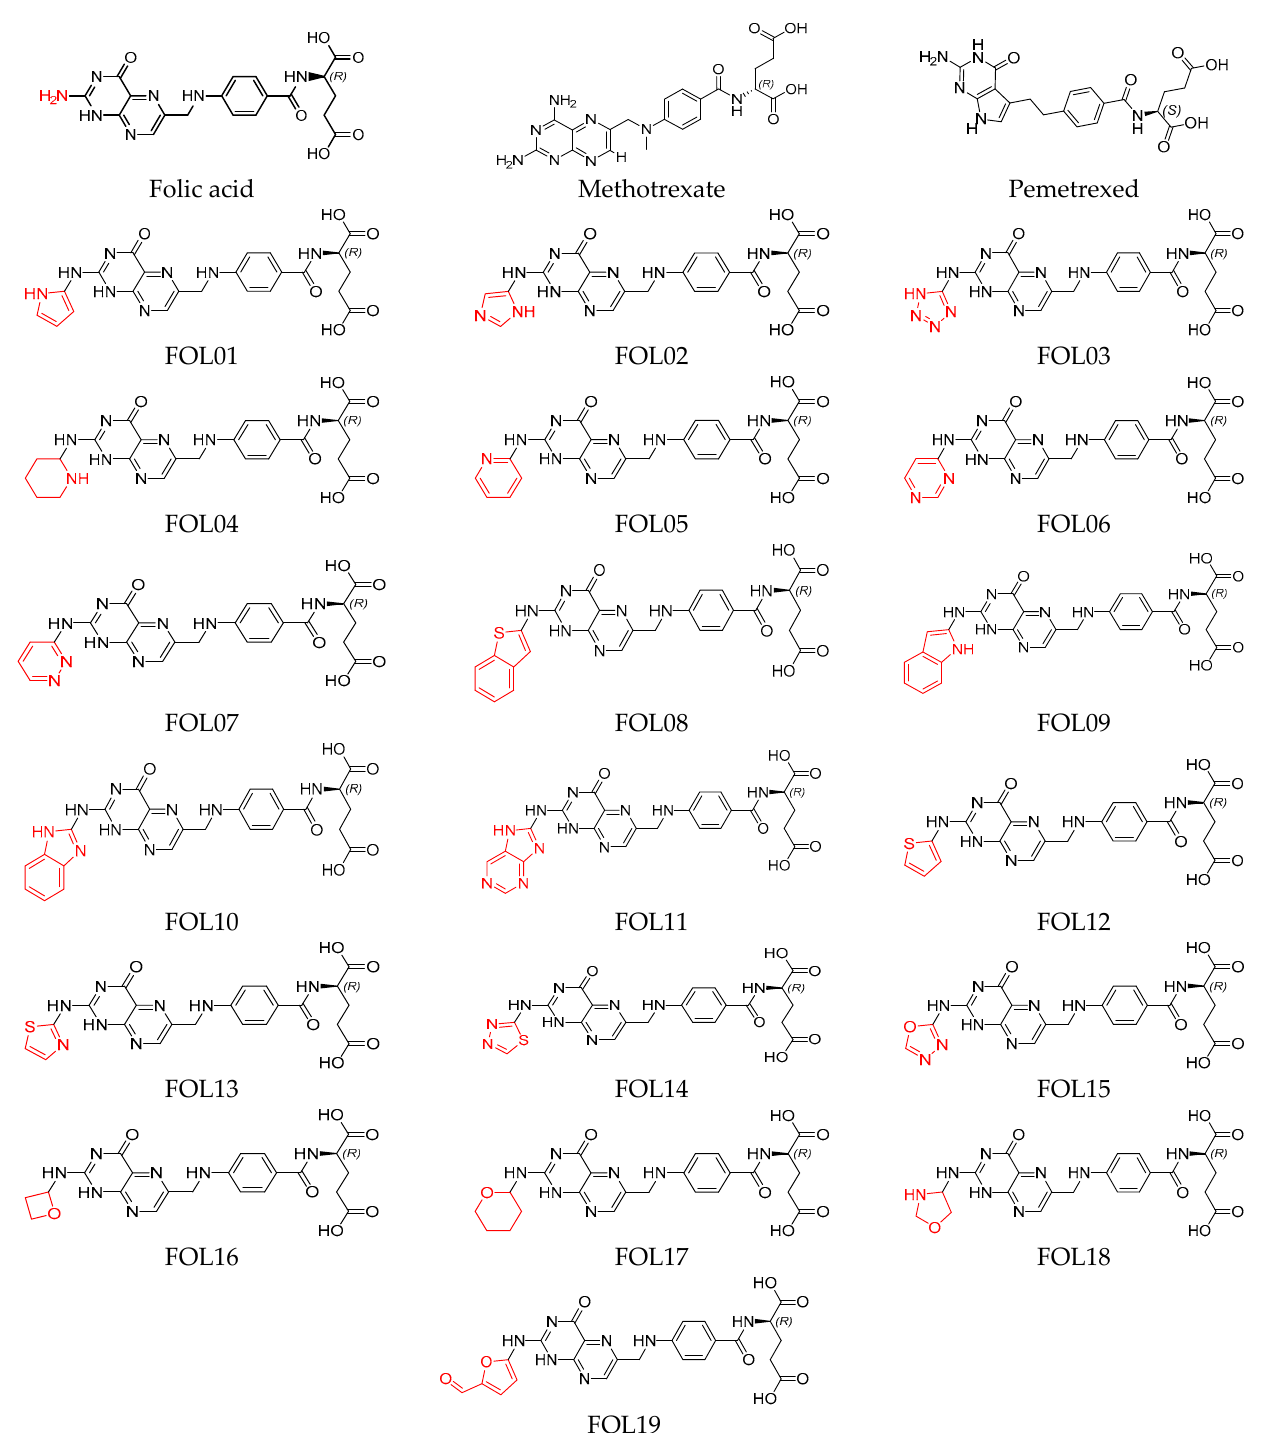
Figure 1. Illustration of the structures for folic acid (FA), methotrexate (MTX), pemetrexed (PTX) and the newly designed FA analogs (FOL1–19). The chemical structure in red is the heterocyclic ring attached to FA.